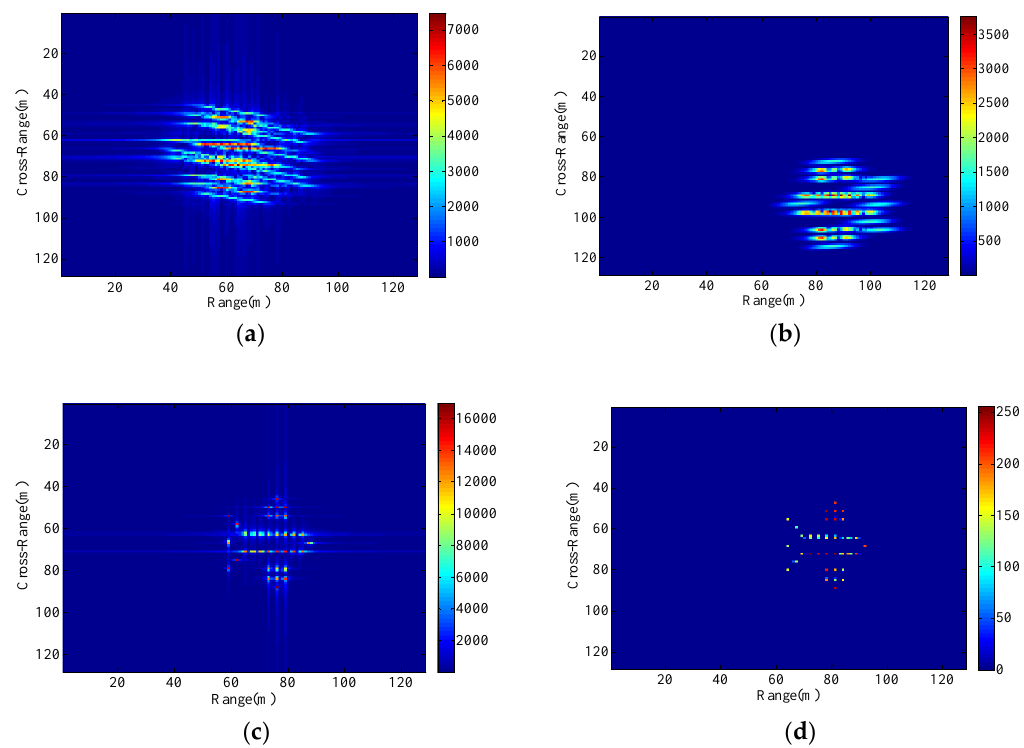
Figure 7. Imaging results with the radar platform displacement parameters P3. ( a ) RD algorithm; ( b ) cross-correlation method; ( c ) minimum entropy method; ( d ) the proposed method.